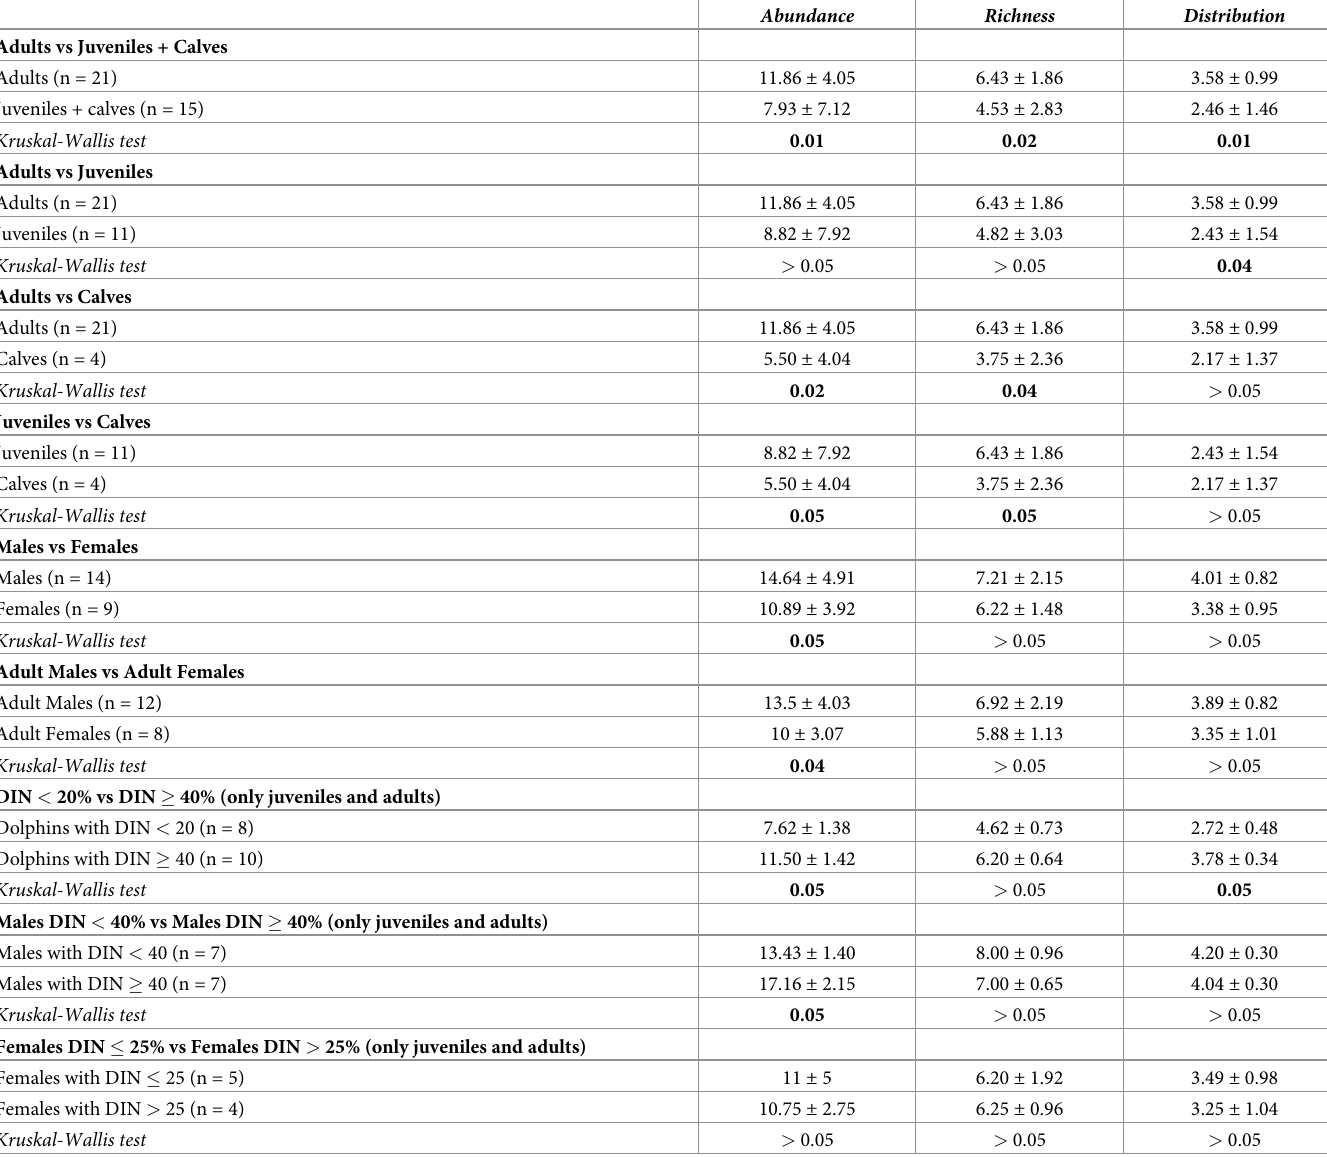
Table 2. Results of Kruskal-Wallis tests conducted on skin marks abundance, richness and distribution. The analyses were carried out for dolphins grouped according to age class (adults, juveniles and calves), sex (males and females) and degree of interaction with trammel nets (DIN). Since DIN values were higher in males (DIN from 25% to 56%, with 50% of males showing a DIN > 40%) than females (DIN from 0 to 36%, with 50% of females showing a DIN > 20%), a 40% threshold was used for males and 25% for females, respectively. Abundance Richness